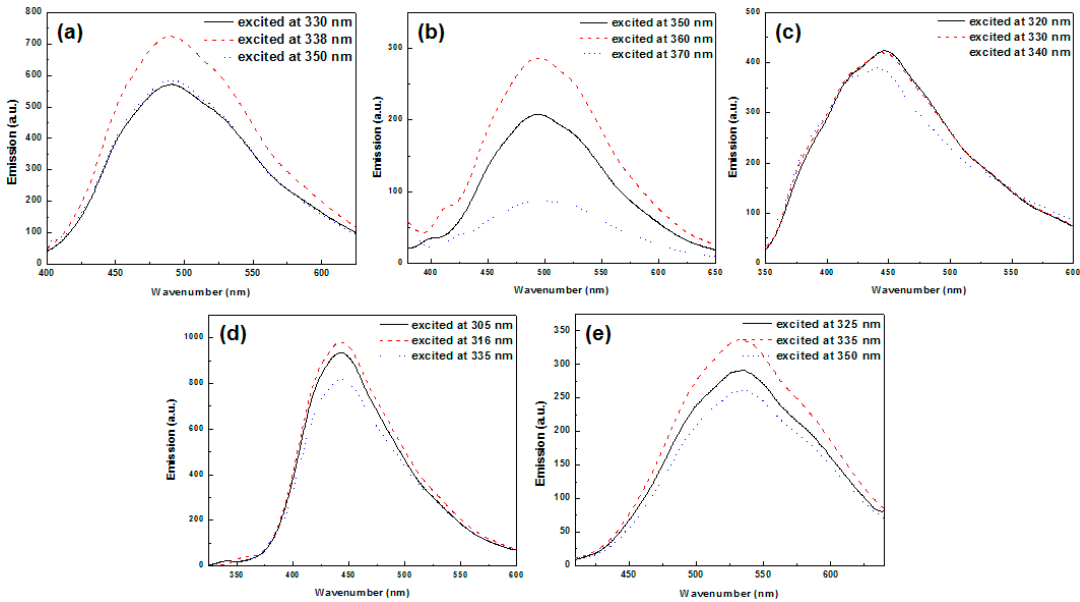
Figure 8. Emission spectra of polymers ( a ) II-1 , ( b ) II-2 , ( c ) II-3 , ( d ) II-4 and ( e ) II-5 in H 2 O at various excitation wavelengths.